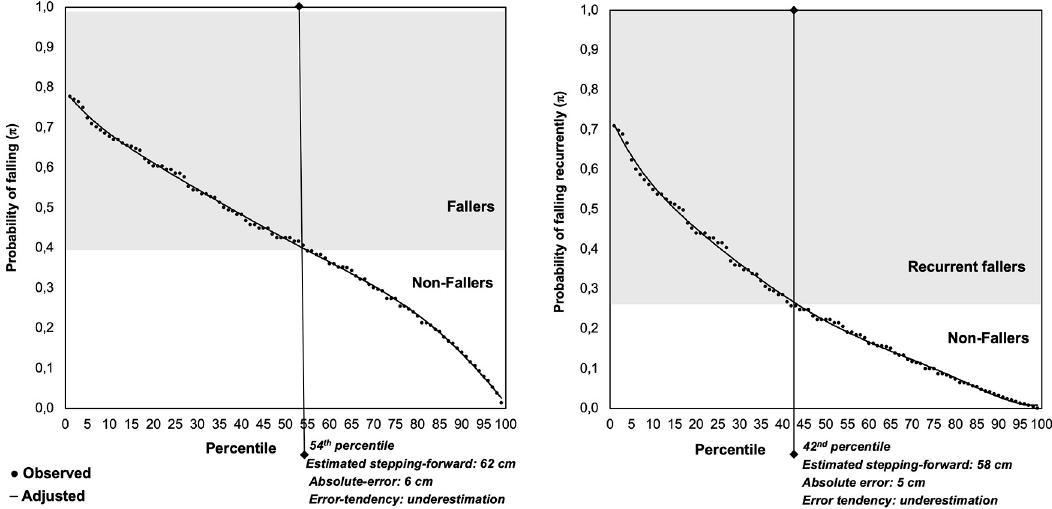
Fig 1. Probability falling and of falling recurrently associated with the key SF-APT outcomes (estimated stepping-forward, and the Absolute-error in interaction with Error-tendency) and respective cut-offs discriminating fallers from non-fallers or recurrent-fallers from